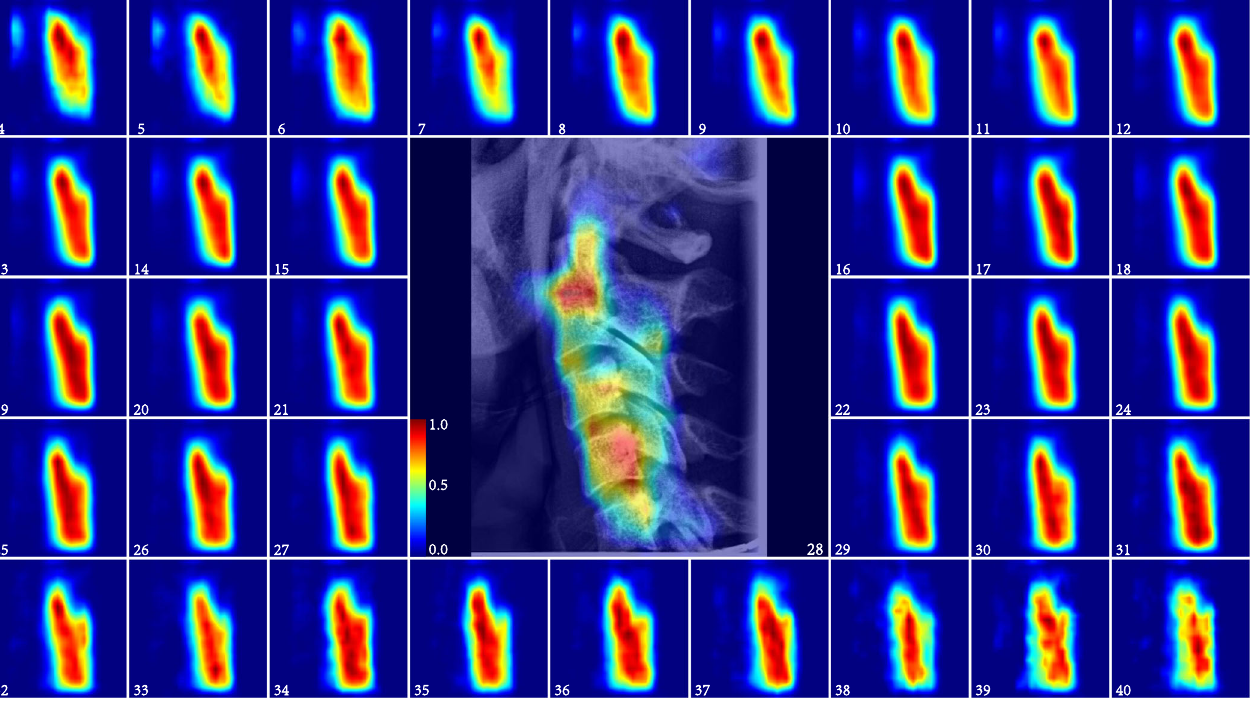
Fig. 5 The ARDA map of the cervical spine region from the ages of 4 to 40 years old. The central panel displays the cervical spine region of a randomly selected 28-year-old subject overlaid with its corresponding ageing salience map to show the relative position between the ARDA map and the cervical spine region of the LCR image. Source data are provided as a Source Data fi le.